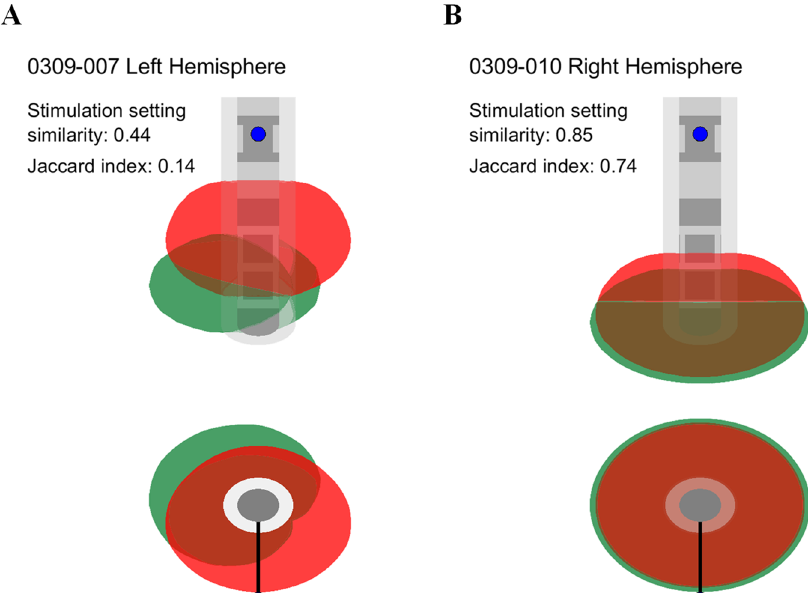
Fig. 3 Exemplary VTAs generated from SoC and AgP DBS settings. Front and top view (upper and lower panels, respectively) of the DBS lead. Grey volume around the lead represents its encapsulation layer. A Subject ’ s 0309-007 left hemisphere SoC and AgP DBS settings have low similarity quanti fi ed by their low stimulation setting similarity and VTA Jaccard index (0.44 and 0.14, respectively). B Subject ’ s 0309-010 right hemisphere SoC and AgP DBS settings have high similarity quanti fi ed by their high stimulation setting similarity and VTA Jaccard index (0.85 and 0.74, respectively). SoC and AgP DBS settings for both subjects are included in Table